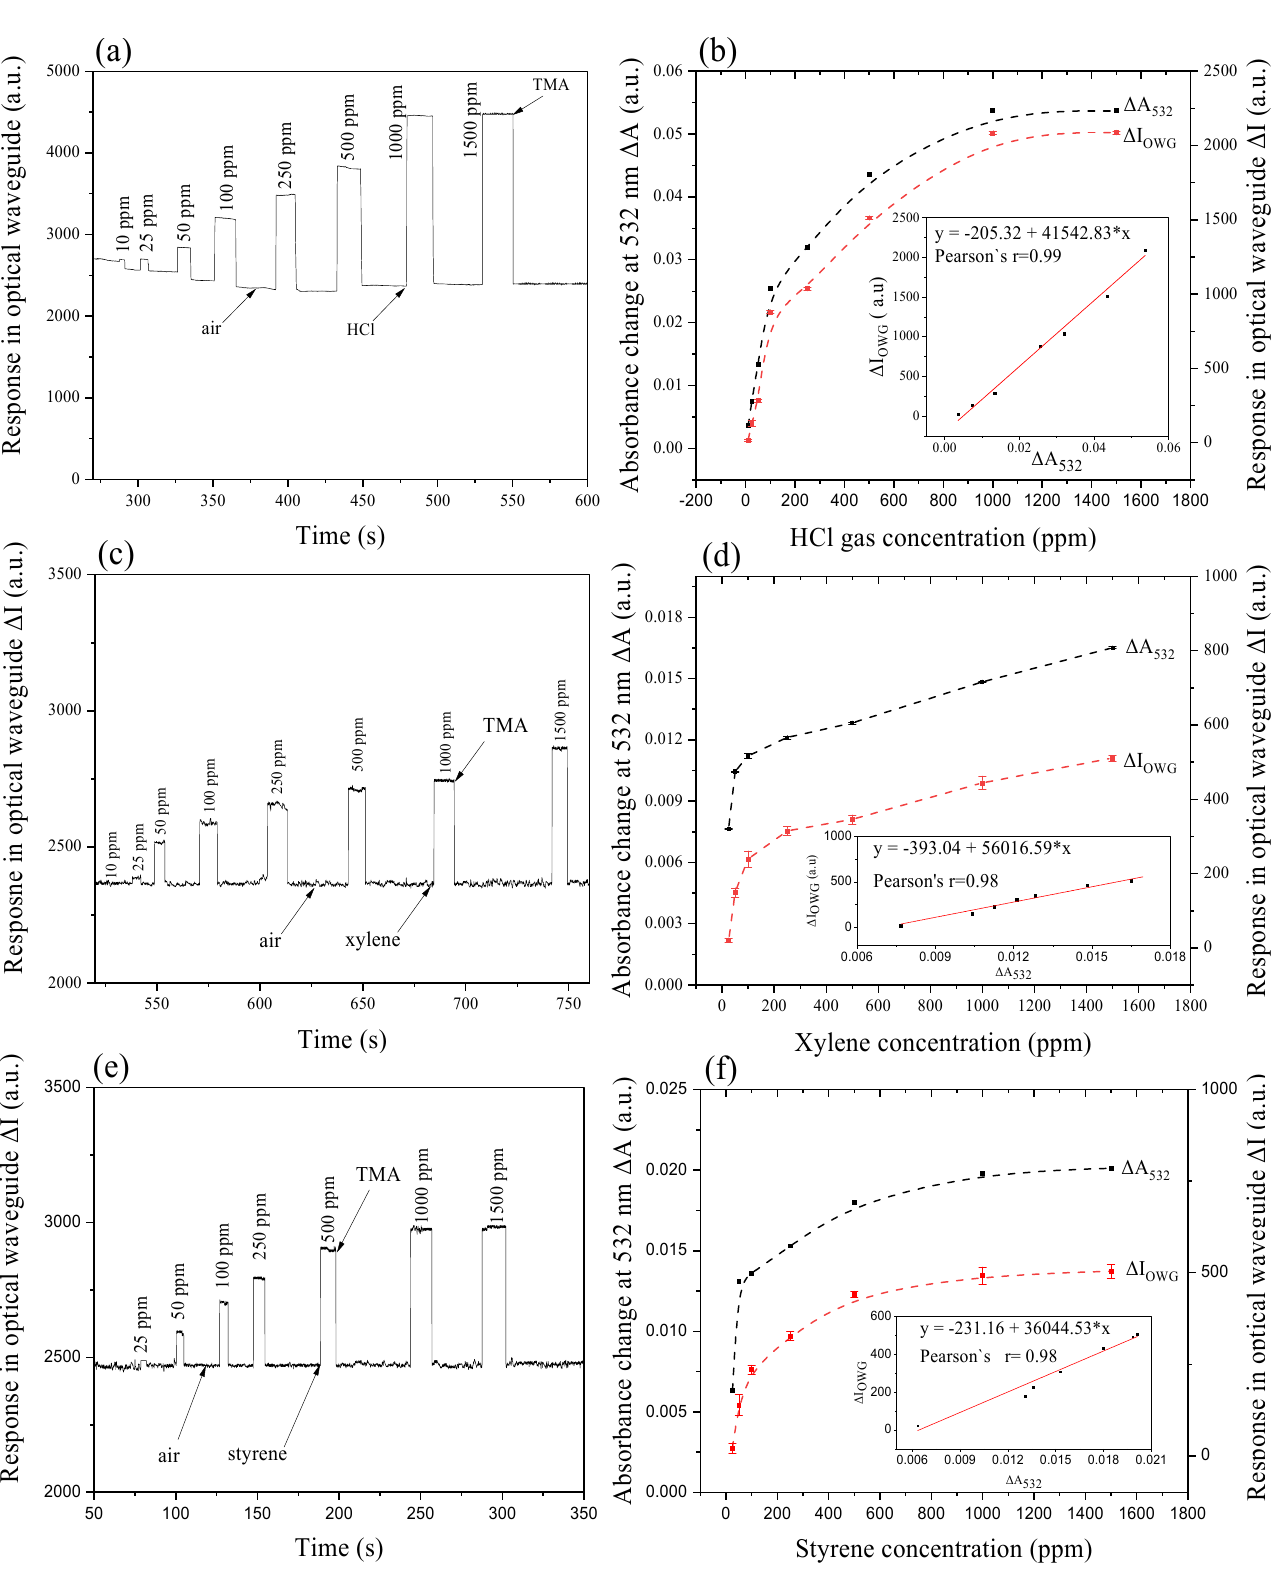
Figure 6. Planar optical waveguide response results along with time ( a,c,e ) HCl, m-xylene, and styrene exposures (10–1500 ppm; ( b,d,f ) correlation of the planar optical waveguide response and absorbance change at 532 nm as a function of gas concentration.